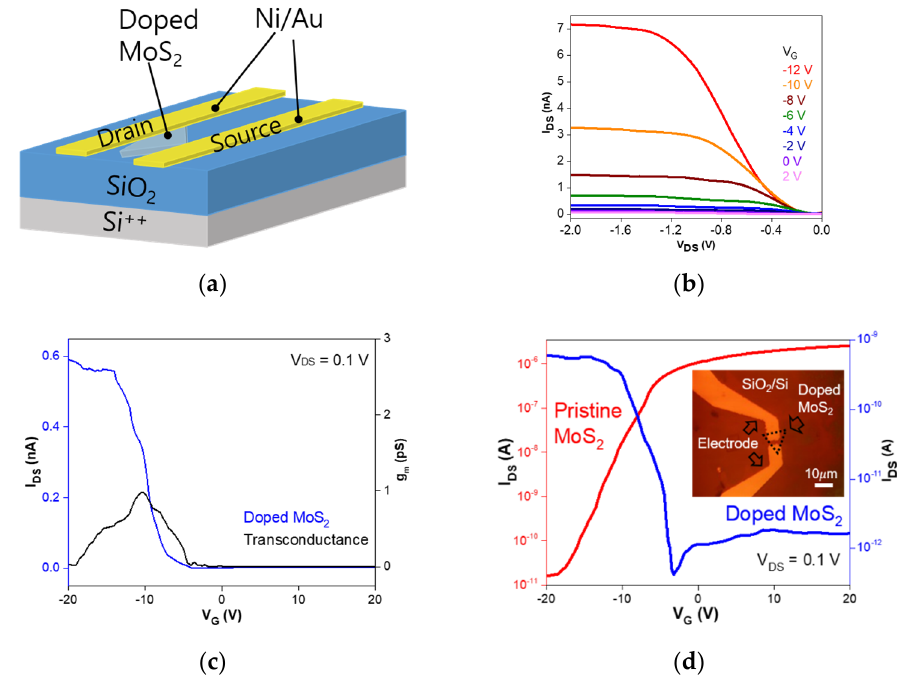
Figure 4. ( a ) Schematic of field-effect transistors (FETs) with a channel length of 3 nm and a channel width of 10 nm. ( b ) I DS –V DS curves of a P-doped monolayer MoS 2 FET with different gate voltages . ( c , d ) Linear and log scales of the transfer characteristics as a function of the gate voltage for FETs with pristine and P-doped MoS 2 channels, respectively.